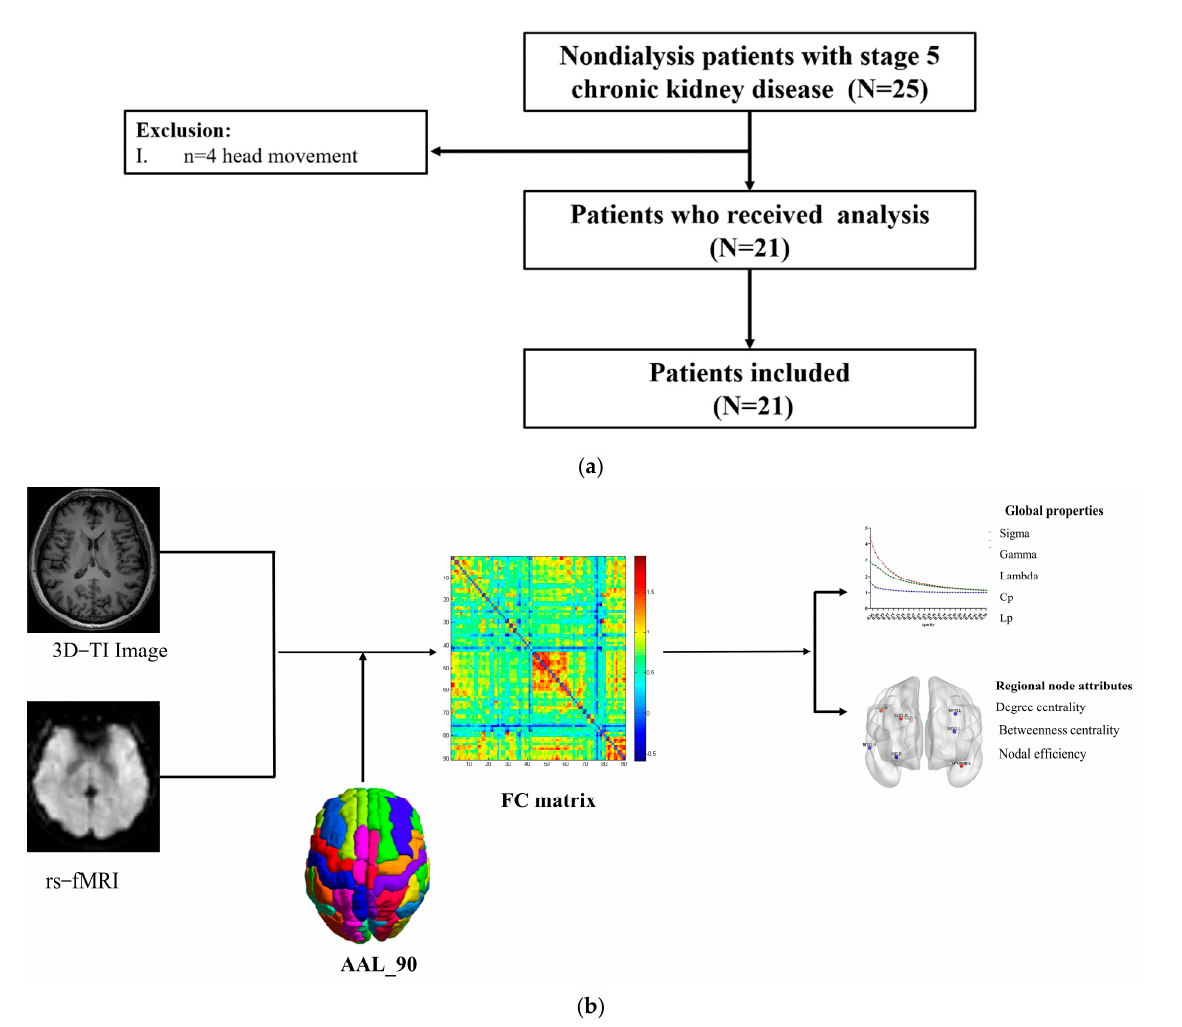
Figure 1. ( a ) Summary of nondialysis patients with stage 5 chronic kidney disease patient recruit- ment and exclusion. ( b ) Flowchart of the MRI signal analysis. AAL, anatomical automatic labeling.